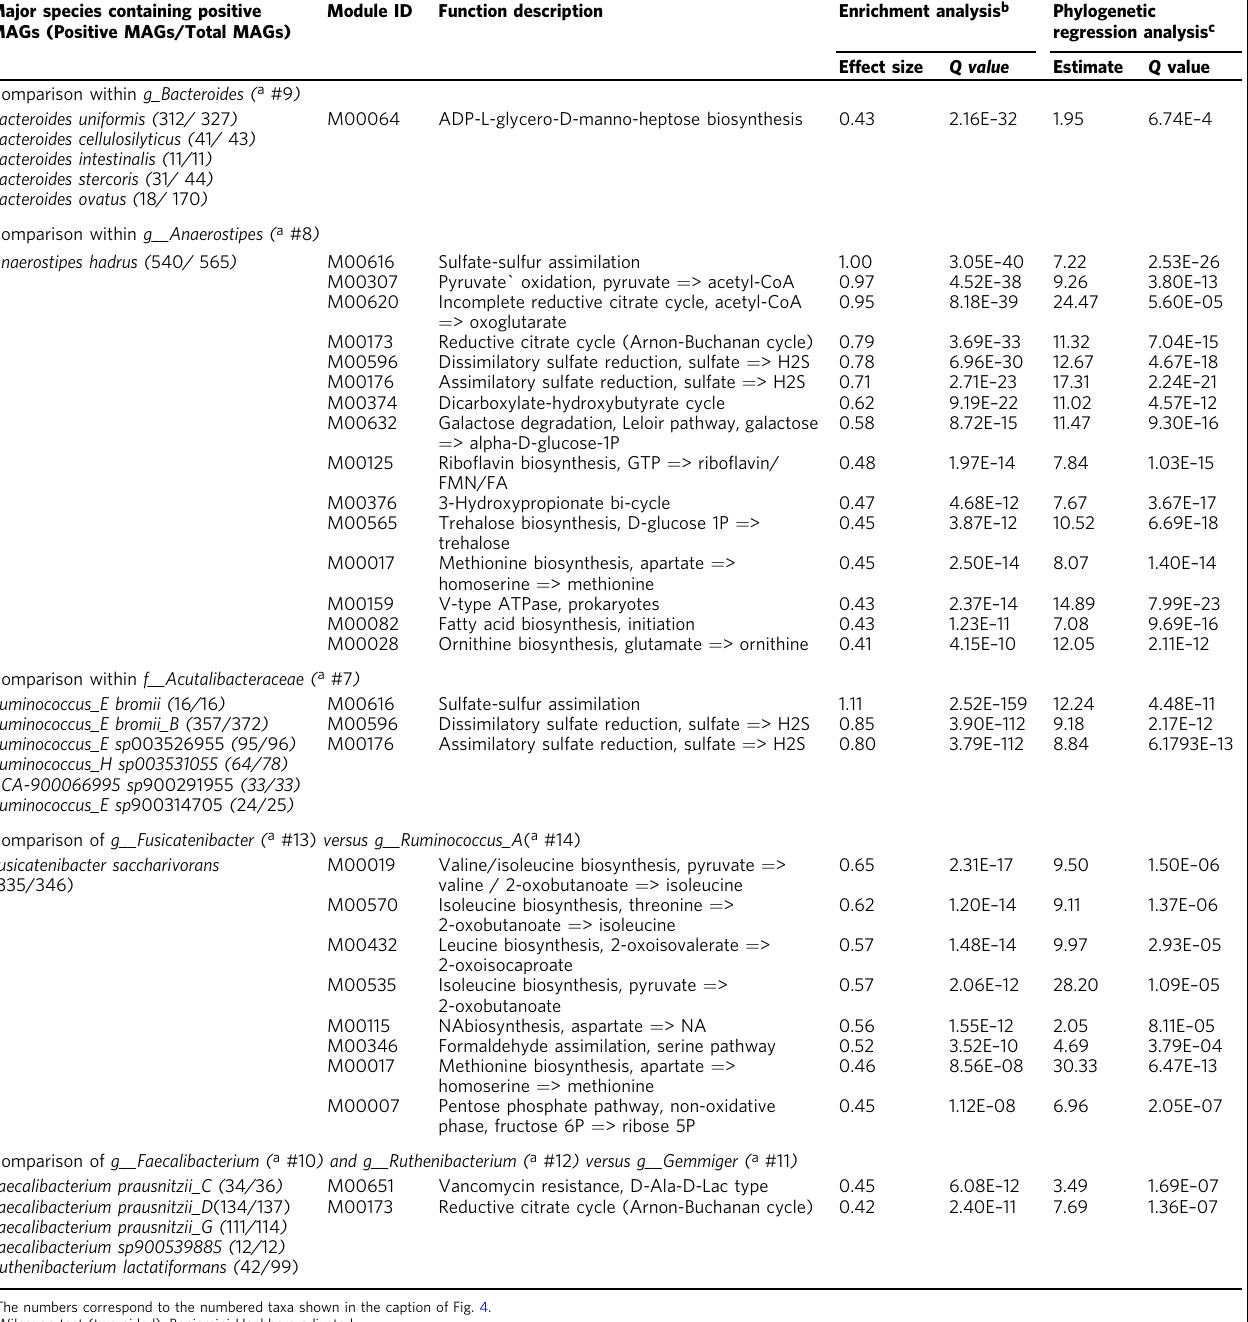
Table 1 Comparative genomics of the taxa containing MAGs positively associated with IA seroconversion. Major species containing positive MAGs (Positive MAGs/Total